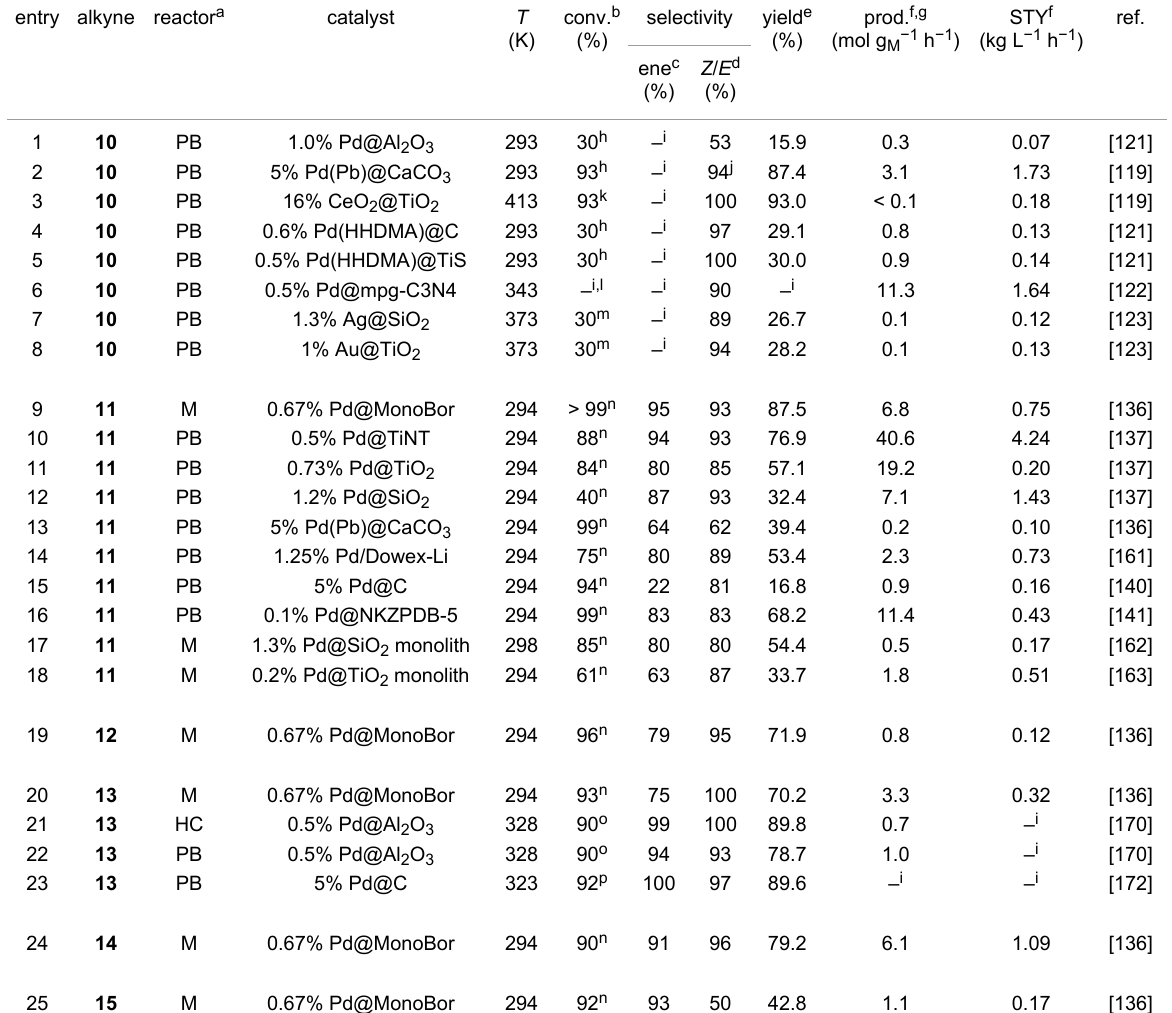
Table 2: Representative continuous flow catalytic processes for liquid-phase partial hydrogenation of internal alkynes. entry alkyne reactor